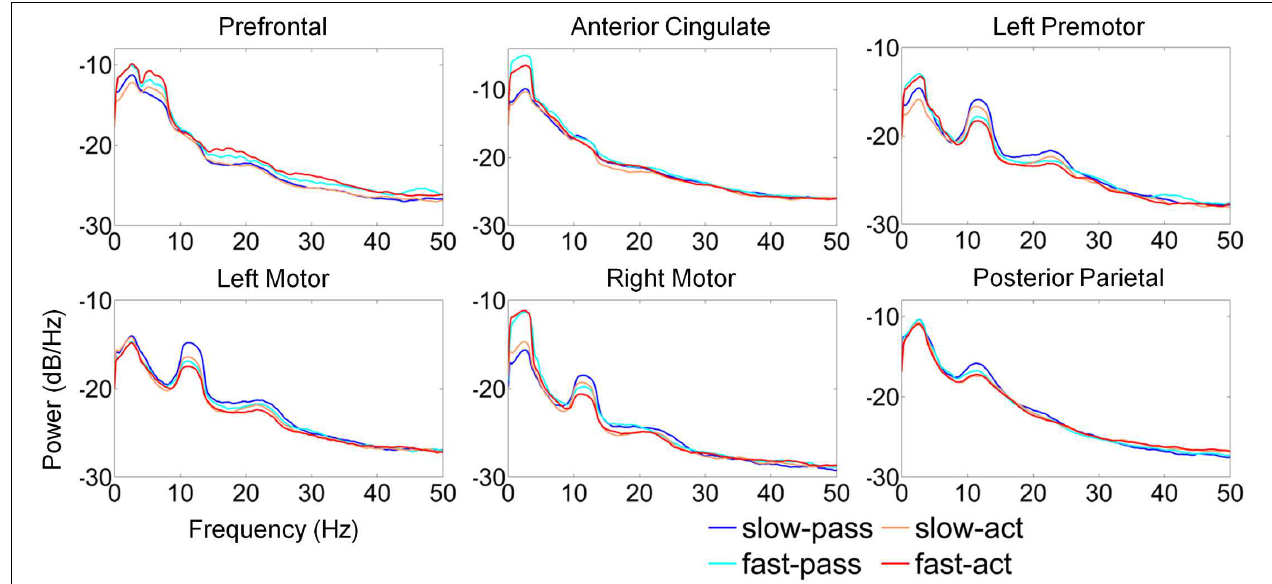
FIGURE 4 | Average power spectra by cluster for the four experimental walking conditions. (1) Passive treadmill, slow speed (slow-pass); (2) passive treadmill, fast speed (fast-pass); (3) active treadmill, slow speed (slow-act); and (4) active treadmill, fast speed